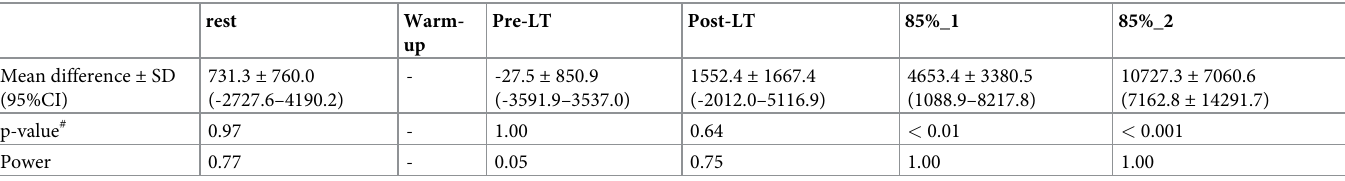
Table 2. Airborne particulate generation during